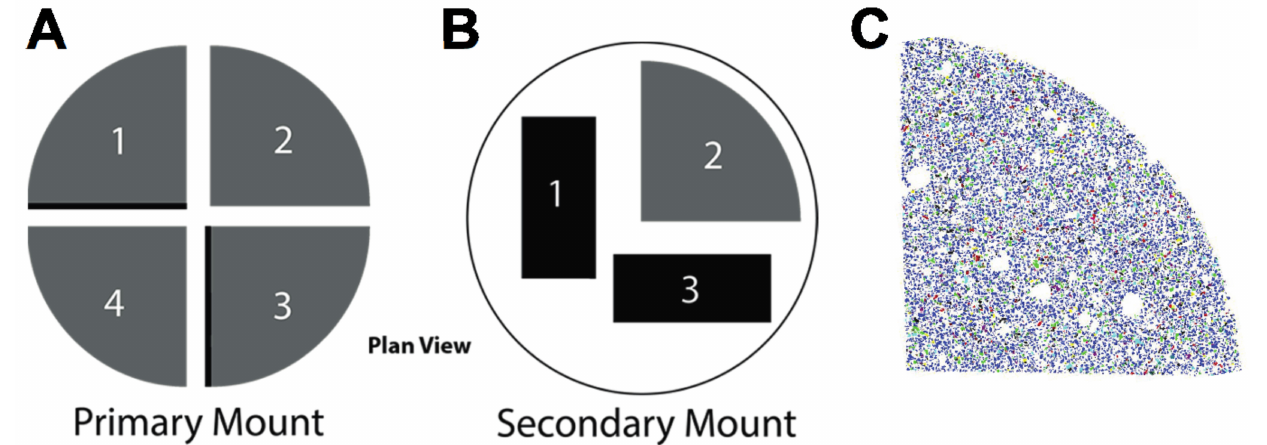
Figure 3. Example of mounting schematic of till in two mounting stages. ( A ) Primary grain mount was quartered, and three quarters are reoriented and made into ( B ) second grain mount that was quartered, and three quarters are reoriented and to display one basal surface and two cross-sectional surfaces for analysis. ( C ) MLA false colour output quarter labelled “2” in B. Cross-sectional surfaces are indicated by the black grey bar in A pane of figure. Modified from Lougheed et al., 2020